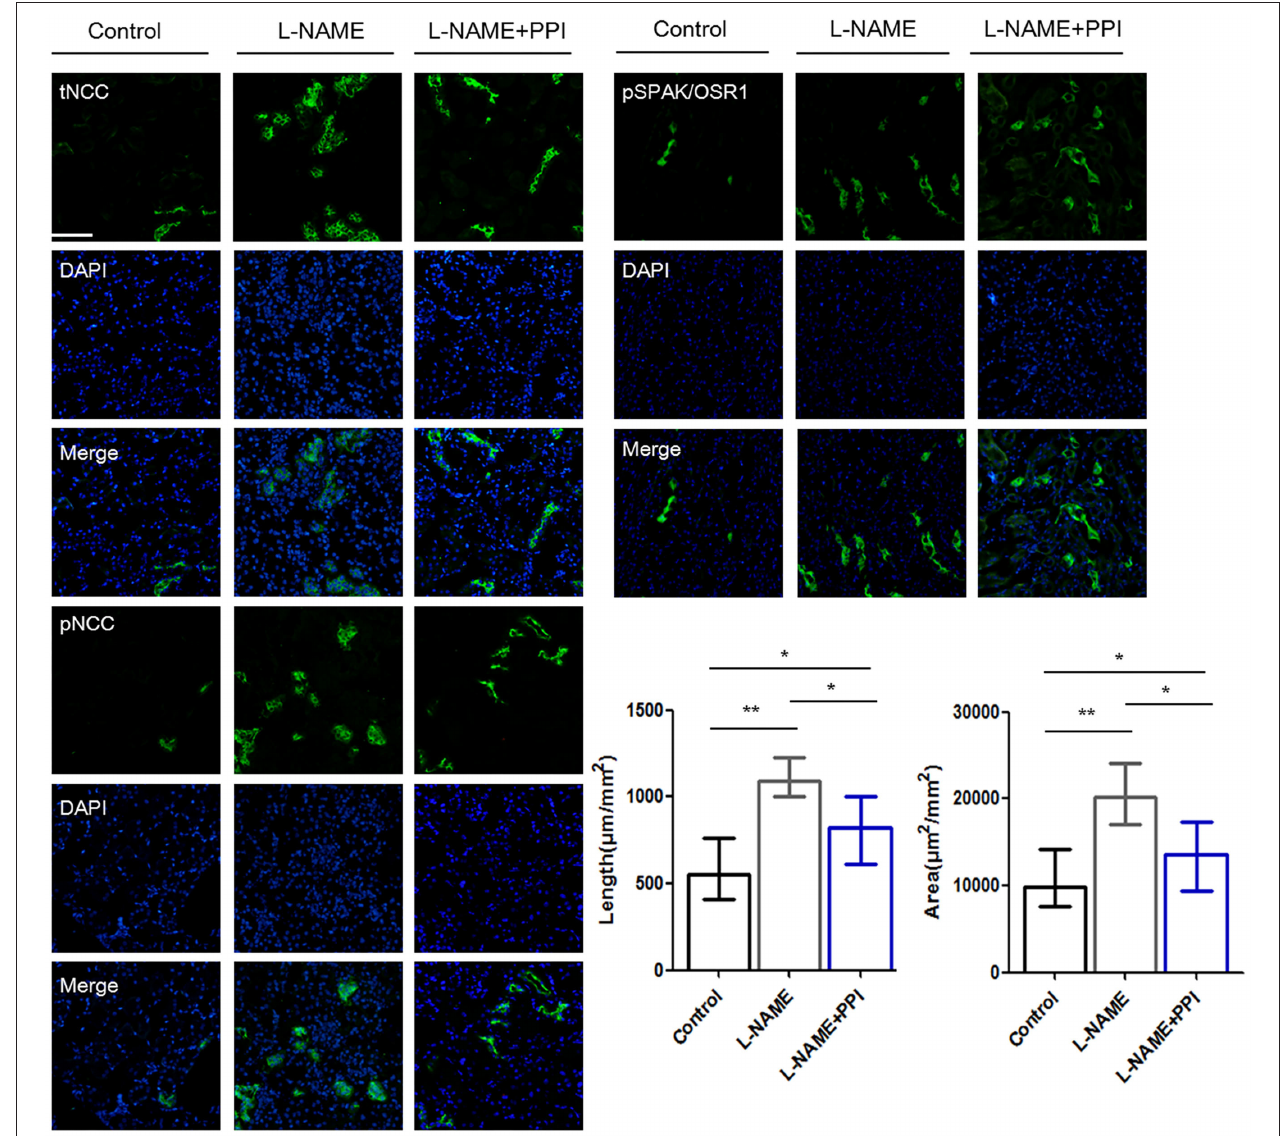
FIGURE 4 | Distal renal tubule remodeling of pregnant L -NAME–treated mice. Representative immunofluorescence images including total NCC (tNCC), phosphorylated NCC (pNCC), and phosphorylated SPAK/OSR1 (pSPAK/OSR1) staining images of the distal renal tubules. Scale bars: 100 µ m. Histological analysis of the length and area expressing tNCC in the distal renal tubule among control ( n = 6), L -NAME ( n = 6), and L -NAME + PPI group ( n = 6) (ANOVA with Tukey post hoc analysis). Data are presented as the mean ± SEM (* p < 0.05 and ** p <